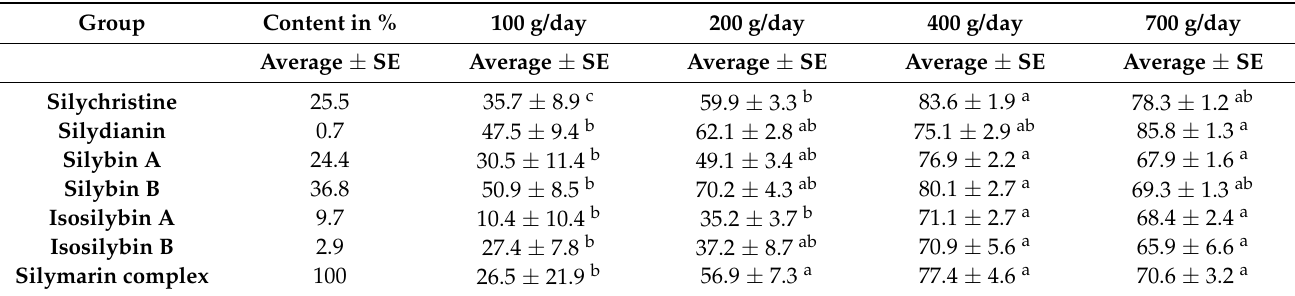
Table 5. Digestibility of silymarin and the individual types of flavonolignans